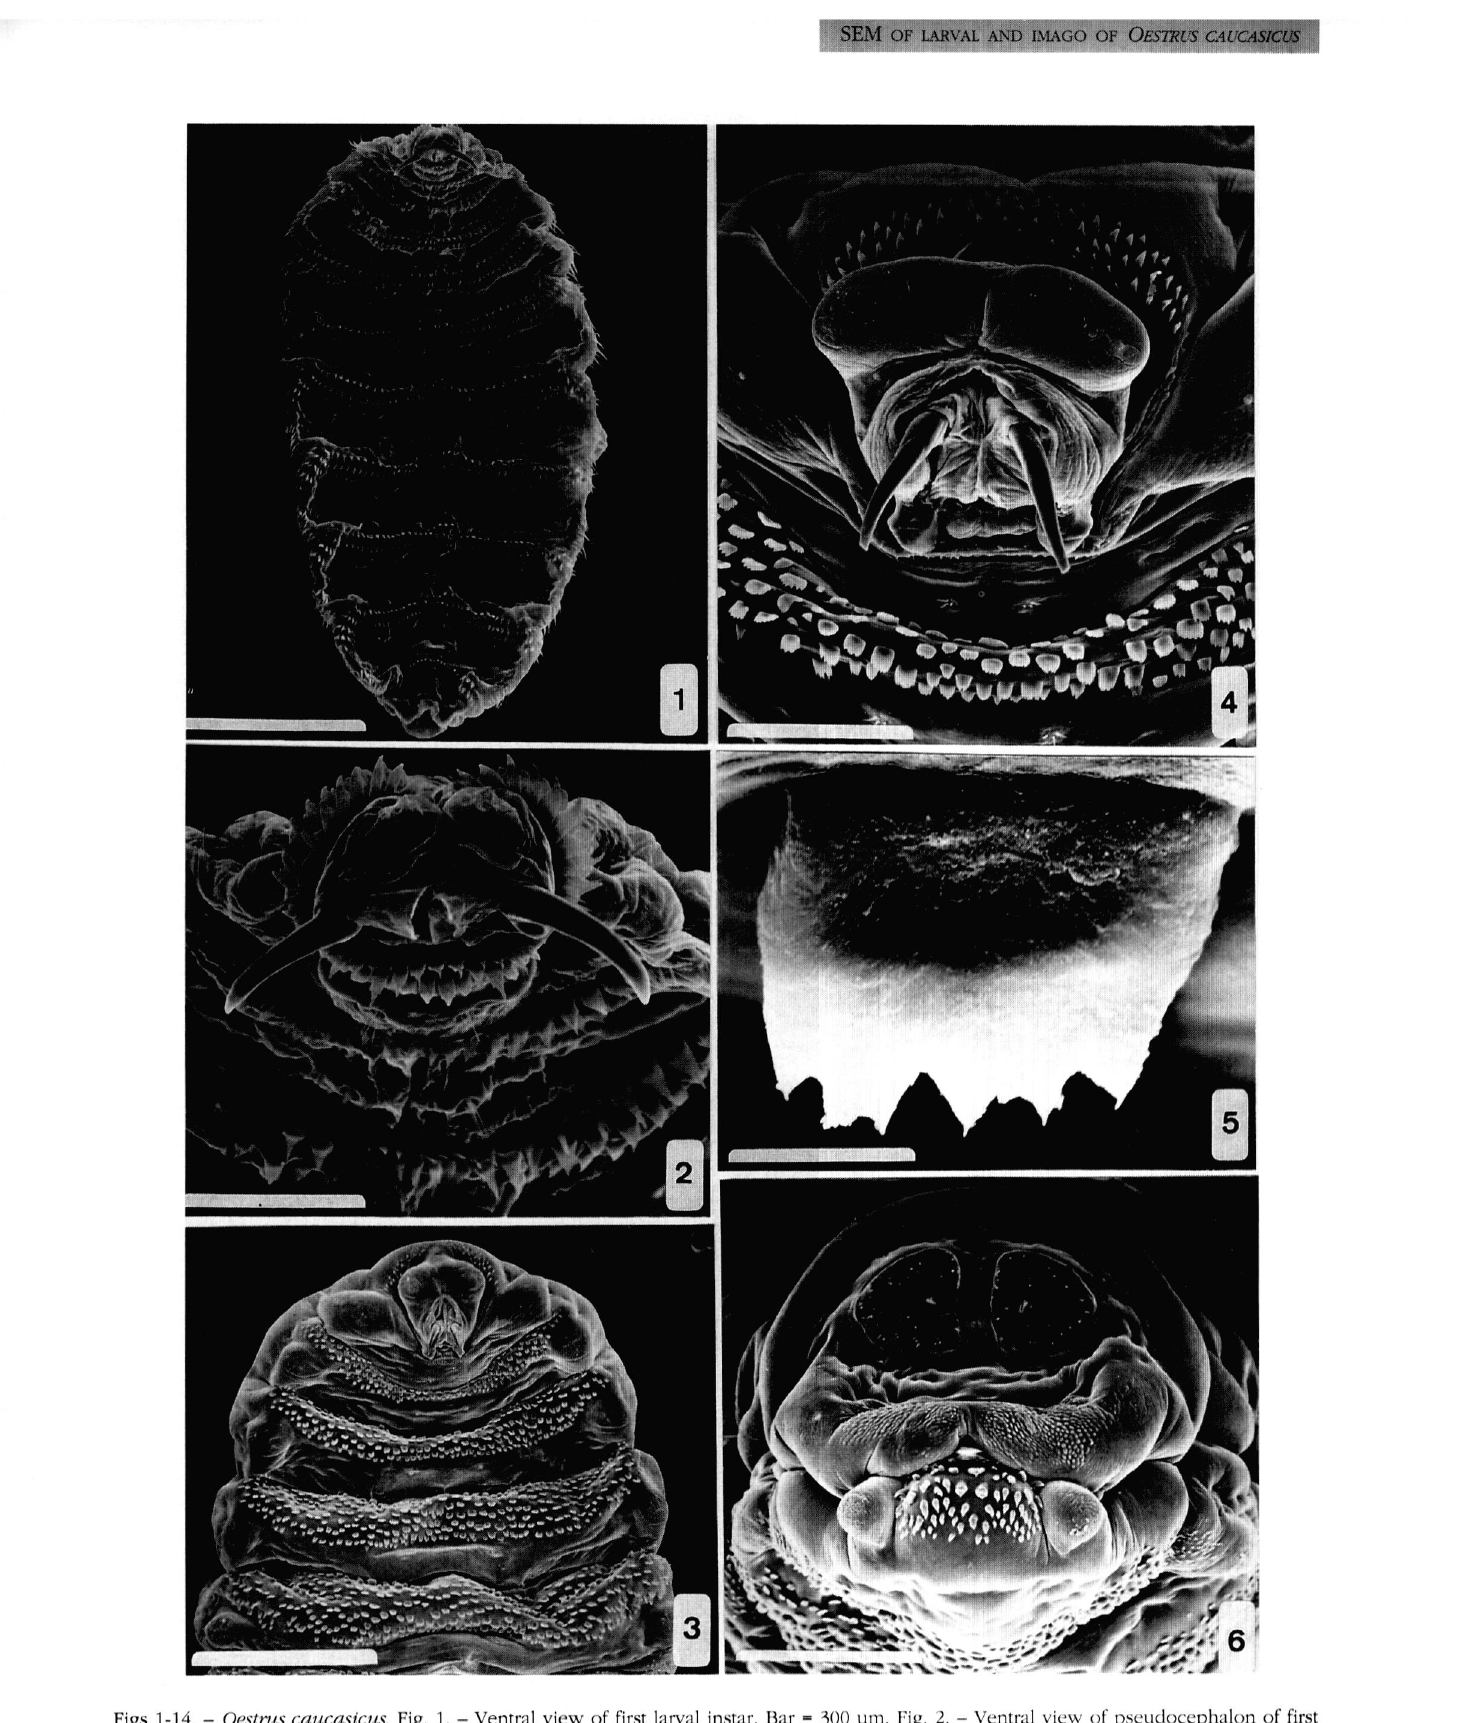
Figs 1-14. - Oestrus caucasicus. Fig. 1. - Ventral view of first larval instar. Bar - 300 urn. Fig. 2. - Ventral view of pseudocephalon of first larval instar. Bar - 60 um. Fig. 3. - Ventral view of anterior part of second larval instar. Bar - 1 000 um. Fig. 4. - Ventral view of pseu­ docephalon of second larval instar. Bar - 200 pm. Fig. 5. - Ventral currycomb-shaped spines of second larval instar. Bar - 12 um. Fig. 6. - Pos­ terior view of posterior end of second larval instar. Bar - 500 pm. Parasite, 2001, 8, 155-160